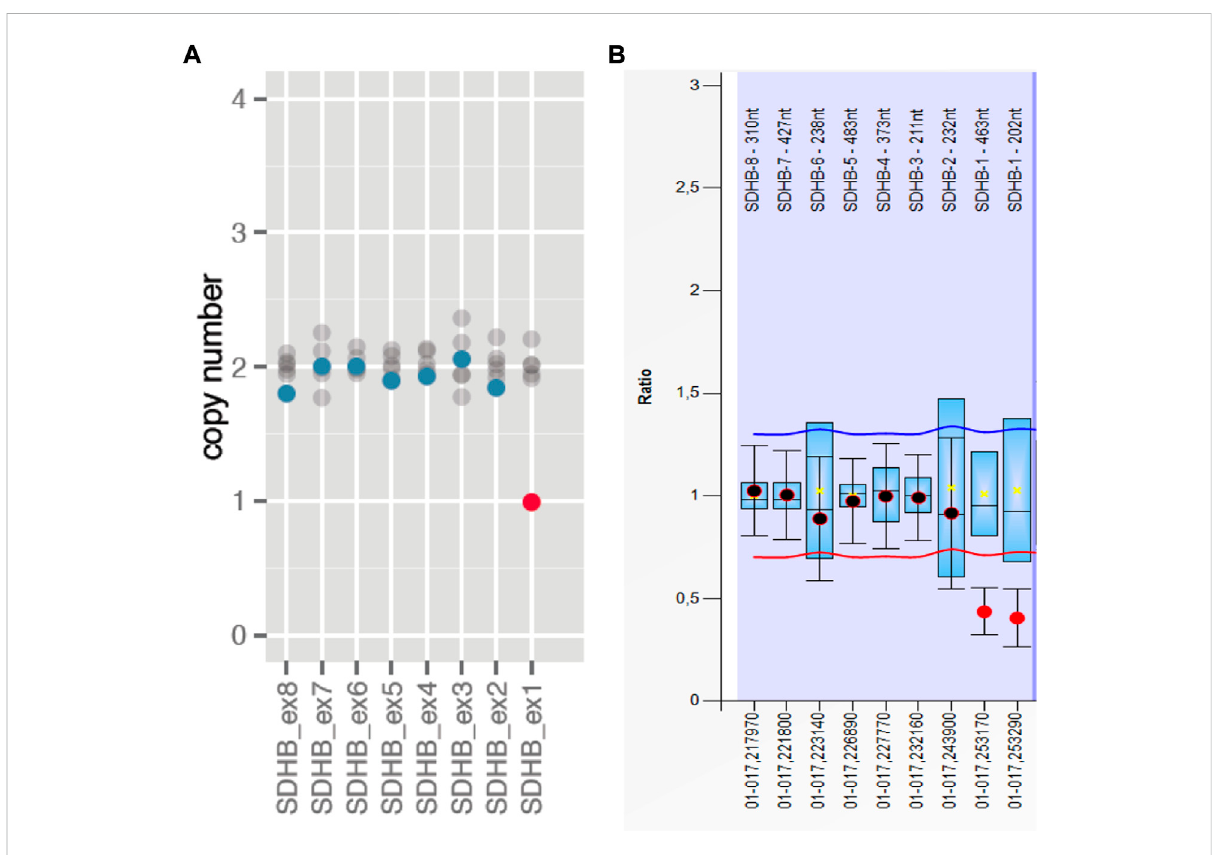
FIGURE 1 RecurrentCNVinthe SDHB geneinColombians consistinginalargedeletion ofonecopyofexon1. (A) Thegraphicshowsthecopynumberof thecarrier(dotsincolorblue/red)andifitissimilar(bluedots)ordifferent(reddots)comparedtothemedianofthecopynumbersofeachexon(1 – 8) among8differentsamples(graydots)includedinthesamerun.Graphicgeneratedandextracted fromSOPHIAGenetics. (B) Correspondinggraphic obtained with MLPA con fi rmatory